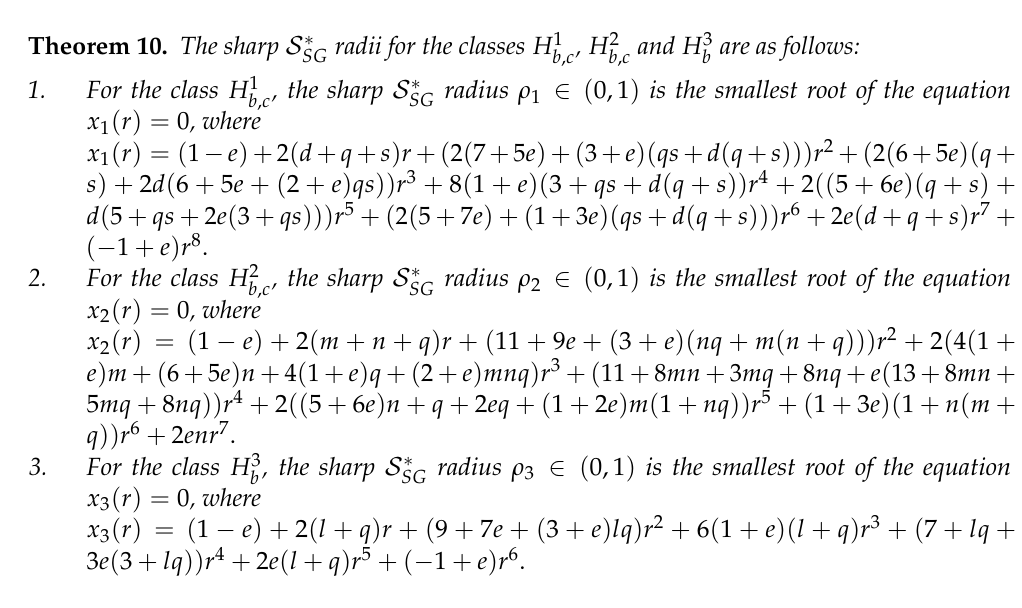
, H 2 and H 3 (b = 1, c = 1, q = b , c b , c b